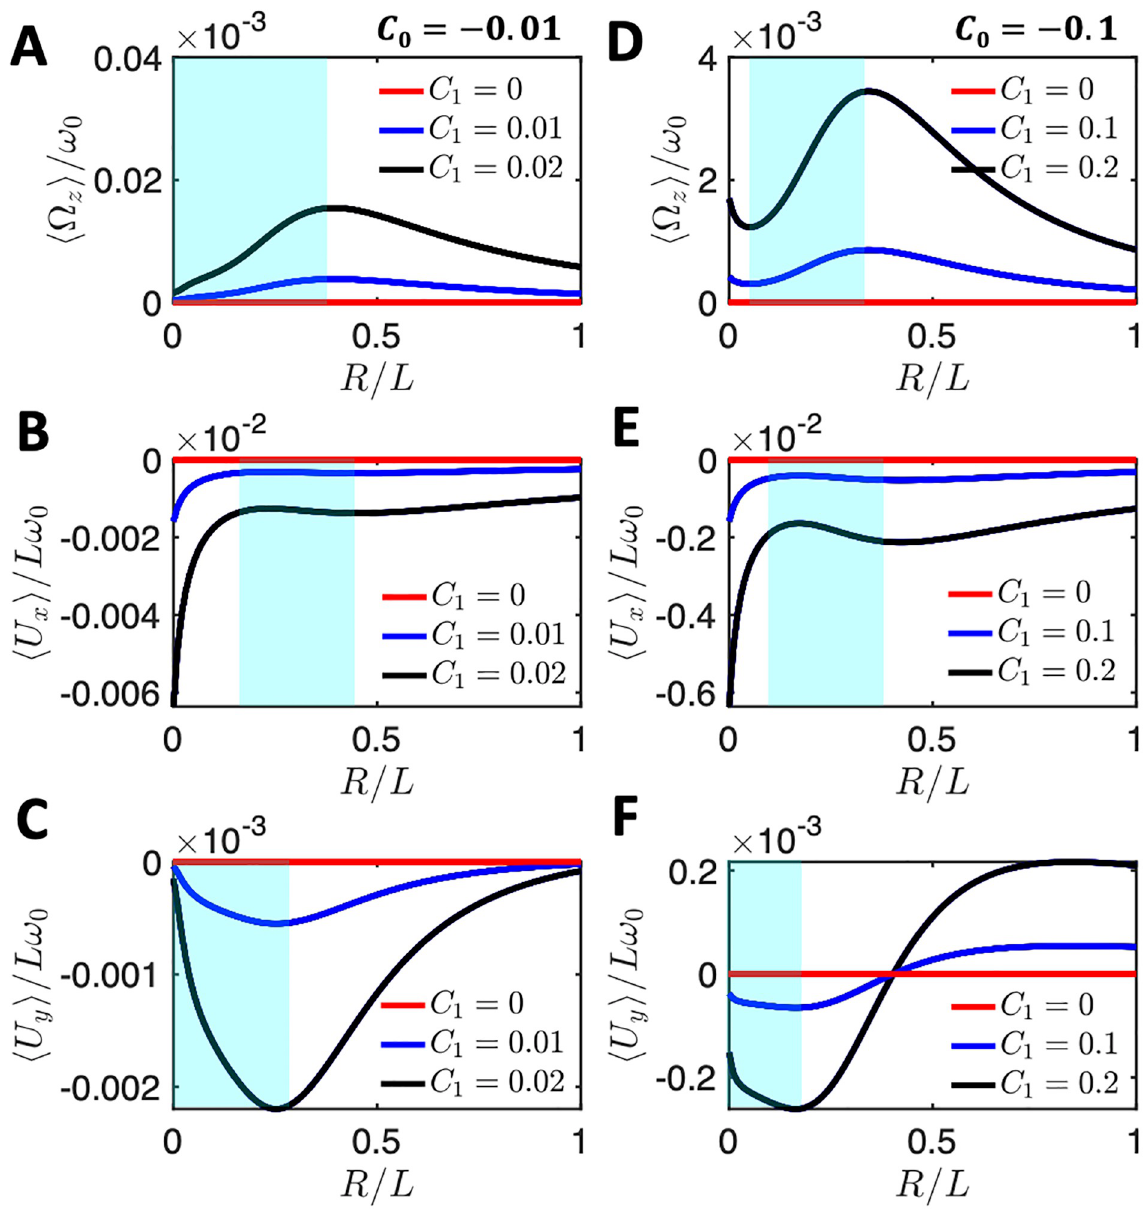
Fig 6. The mean rotational and translational velocities of a bead which is asymmetrically attached to an axoneme with y b = − r and x b = 0 for different values of C 1 , as a function of the dimensionless ratio r = R / L . The mean curvature C 0 is − 0.01 in panels A-C and − 0.1 for panels D-F. For a sketch of the bead-axoneme attachment geometry see Fig